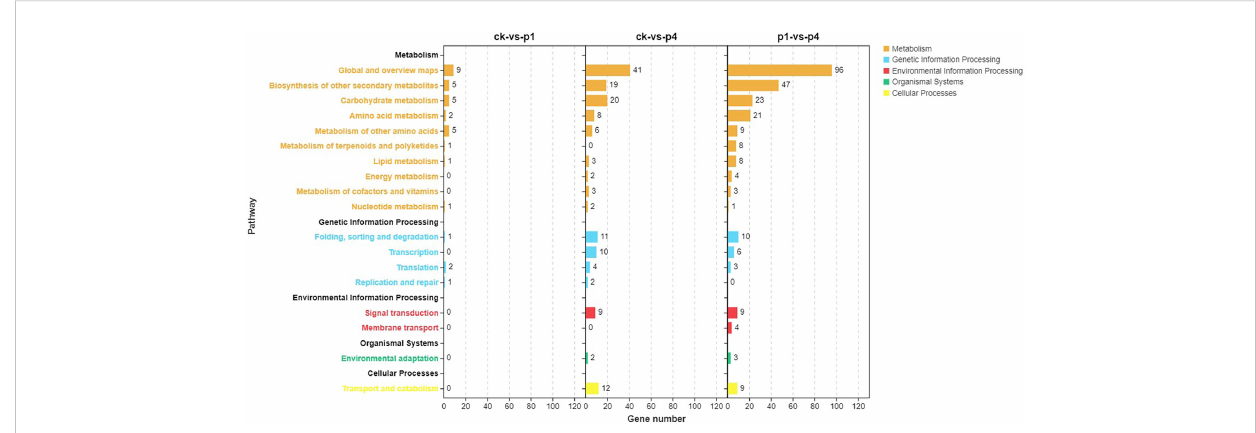
FIGURE 4 Kyoto Encyclopedia of Genes and Genomes (KEGG) pathway analysis of DEGs after cooling under different P treatments. DEGs, differentially expressed genes; KEGG, Kyoto Encyclopedia of Genes and Genomes; P,